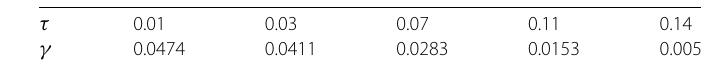
Table 2 The allowed upper bound γ for different